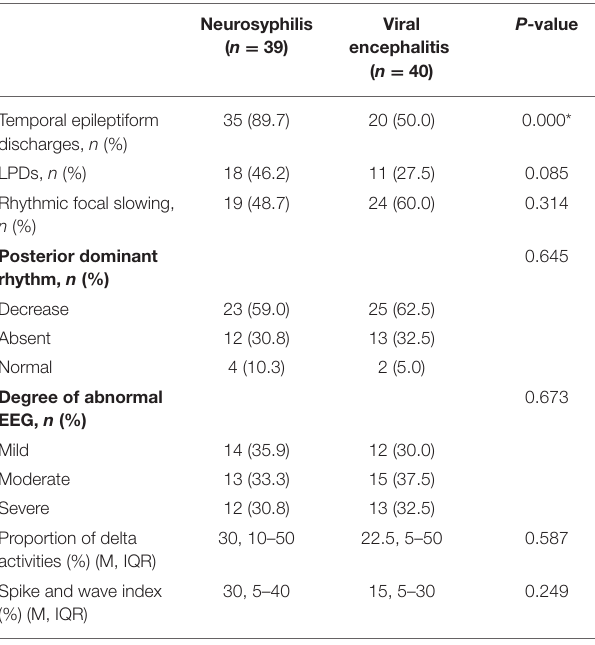
TABLE 3 | Comparison of patients with seizures due to neurosyphilis vs. viral encephalitis after age and sex